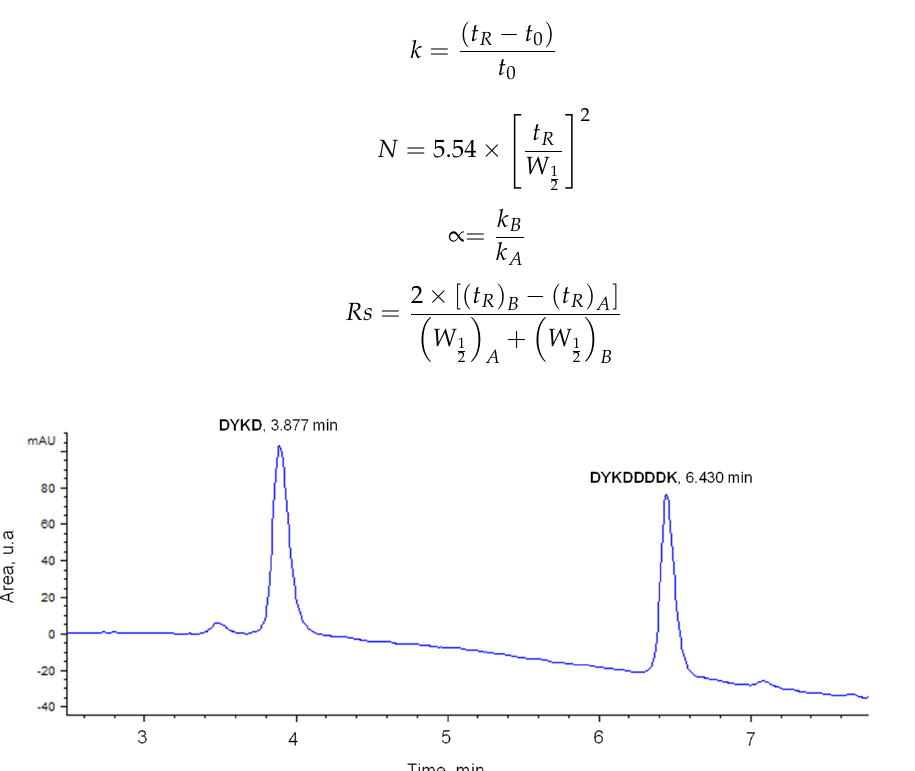
Figure 1. Chromatogram obtained from the analysis of a standard solution of the peptides DYKDD and DYKDDDDDDK (20 mg ∙ L − 1 ). Table 2. Chromatographic parameters calculated from the standard solutions of DYKDDD and